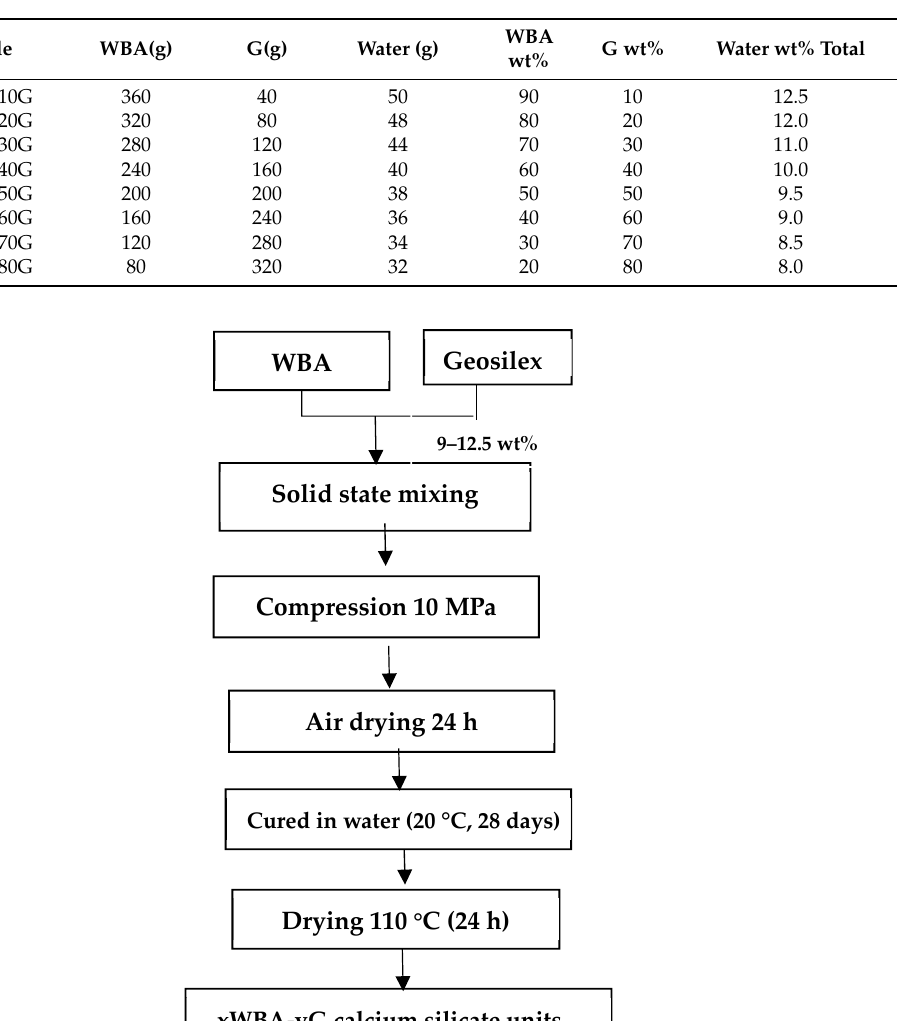
Table 1. Designation of calcium silicate units and raw materials, wood bottom ash, GeoSilex and water content of ten specimens.